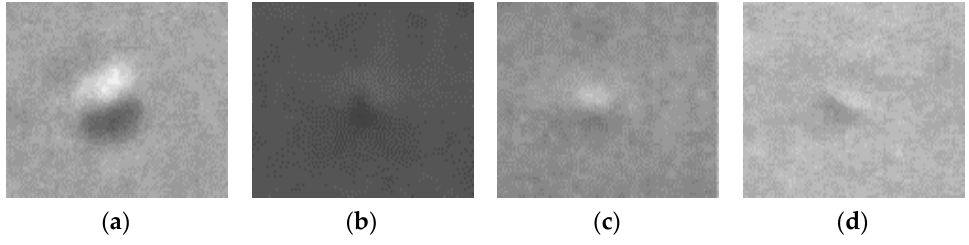
Figure 9. Various pit defects used to train the detection model; ( a – d ) training sample images.